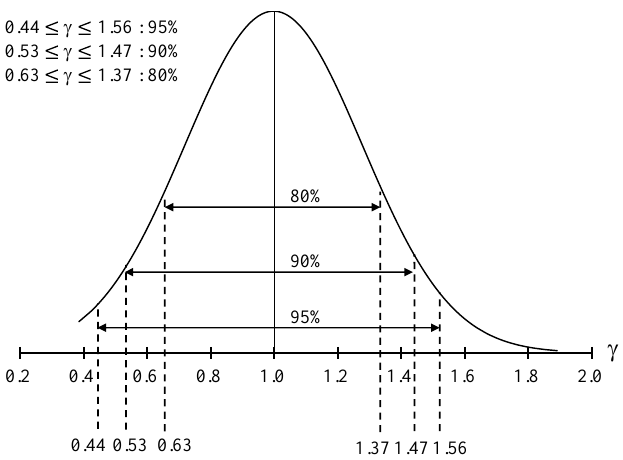
Figure 4. The normal distribution curve of γ .